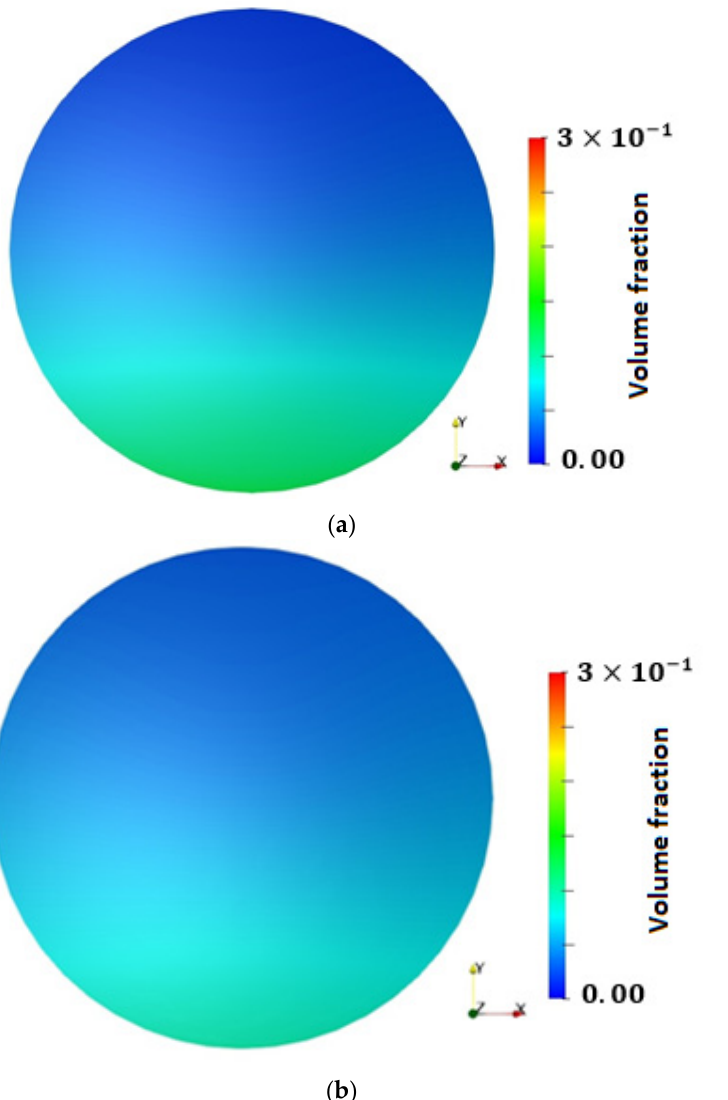
Figure 7. Distribution of water volume fraction across pipe section ( a ) test 1 (V = 1.25 m/s, water cut = 0.05), ( b ) test 2 (V = 1.7 m/s, water cut = 0.05).